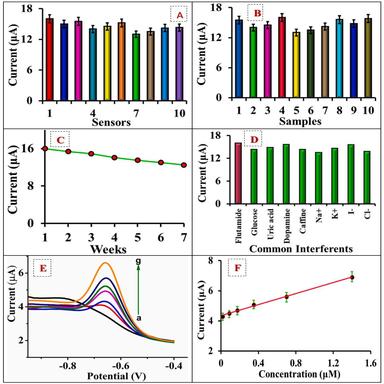
A) Inter-assay: electrochemical signal change response of 12 μM FLT at 10 different sensors; B) intra-assay: voltammetric response at the same sensor repetitively for 10 times at a certain concentration of FLT (12 μM); C) the time stability study of the GQDs@La3+@ZrO2/GCE sensor for detection of FLT; D) influence of various interfering agents on the electrochemical response of FLT; E) SWVs of FLT in a urine sample at different concentrations (0.0175–1.4 μM); H) Calibration curve between concentration vs pea